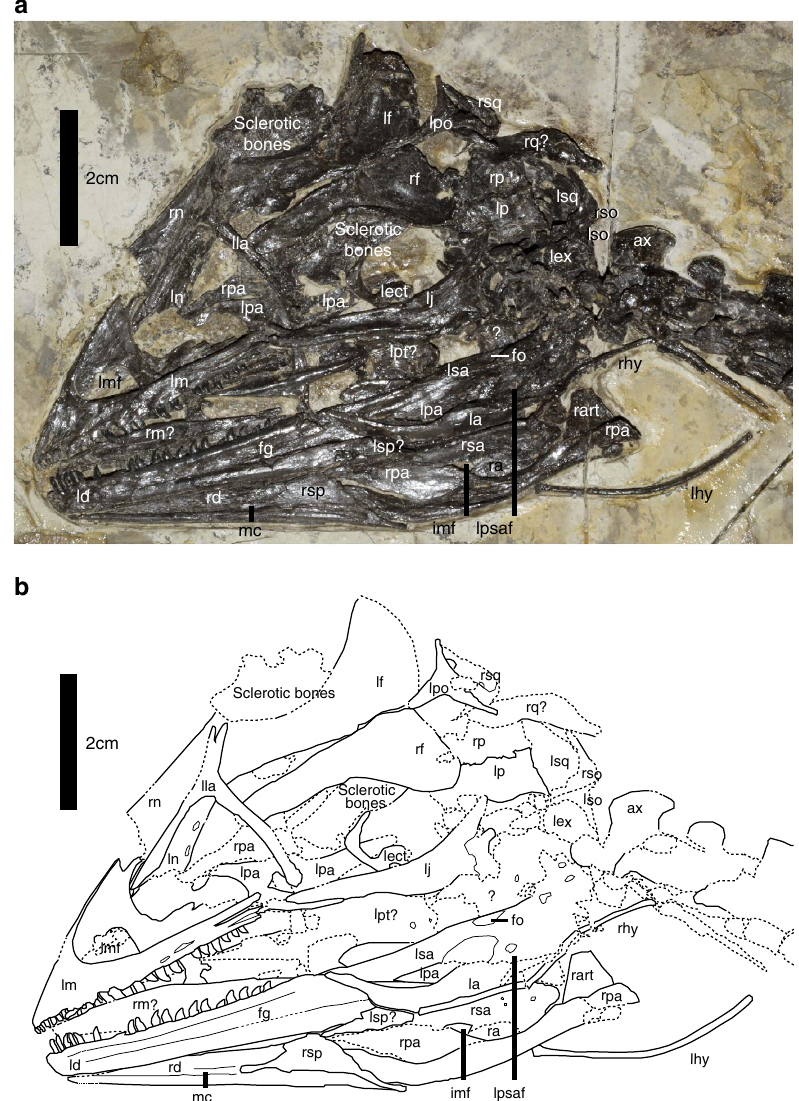
Figure 2 | Cranium of Jianianhualong tengi holotype DLXH 1218. ( a ) Photograph and ( b ) line drawing of the skull and mandible. Scale bar, 2cm. ax, axis; fg, groove with foramina; fo, fossa; imf, internal mandibular fenestra; la, left angular; ld, left dentary; lect, left ectopterygoid; lex, left exoccipital; lf; left frontal; lhy, left hyoid bone; lj, left jugal; lla, left lacrimal; lm, left maxilla; lmf, left maxillary fenestra; ln, left nasal; lp, left parietal; lpt?, left pterygoid?; lpa, left prearticular; lpo, left postorbital; lpsaf, left posterior surangular foramen; lsa, left surangular; lsp?, left splenial?; lso, left supraoccipital; lsq, left squamosal; mc, Meckelian canal; ra, right angular; rart, right articular; rd, right dentary; rf, right frontal; rhy, right hyoid bone; rm?, right maxilla?; rn; right nasal; rp, right parietal; rpa, right prearticular; rq?, right quadrate?; rsa; right surangular; rso, right supraoccipital; rsp; right splenial; rsq, right